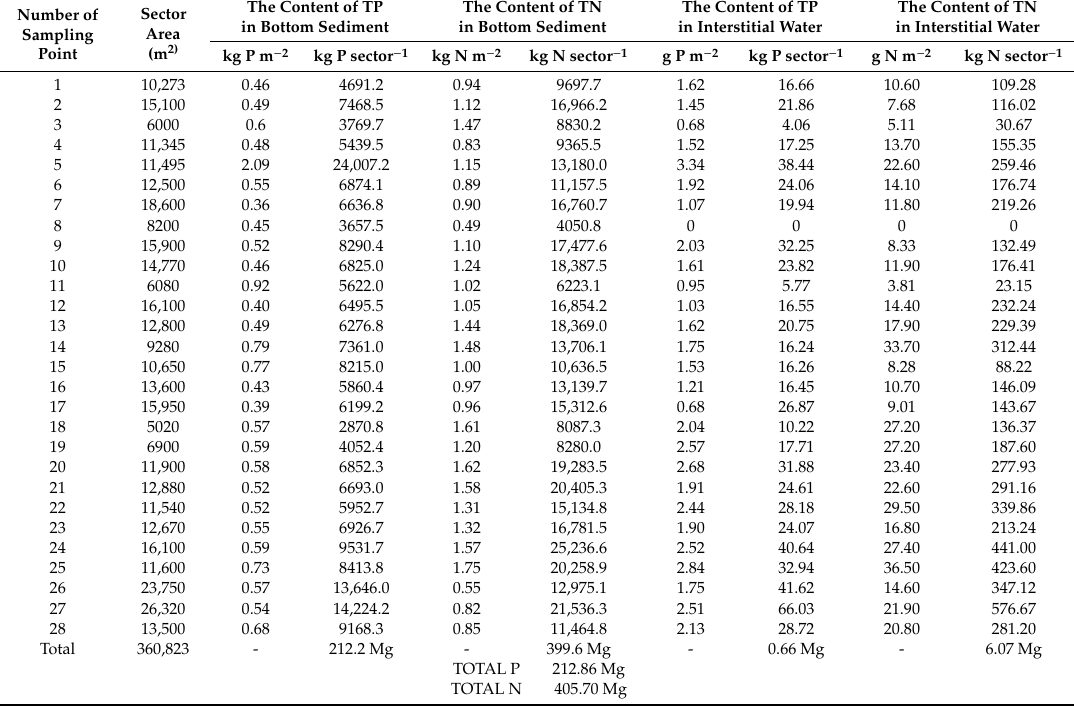
Table 5. The load of phosphorus and nitrogen can be withdrawn from the Karczemne Lake with bottom sediments and interstitial